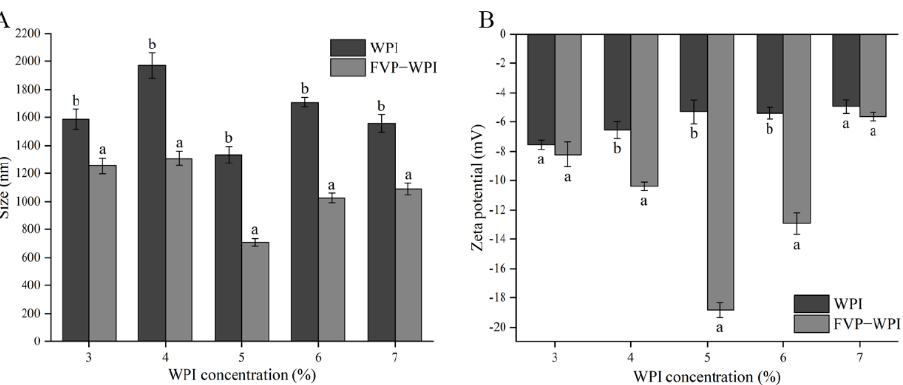
Figure 1. Characterization of whey protein isolate (WPI) and Flammulina velutipes polysaccharide (FVP)–WPI particles at pH 4.5. ( A ) Particle size; ( B ) zeta potential. Different letters in the figure represent significant differences in different samples of the same concentration ( p < 0.05).